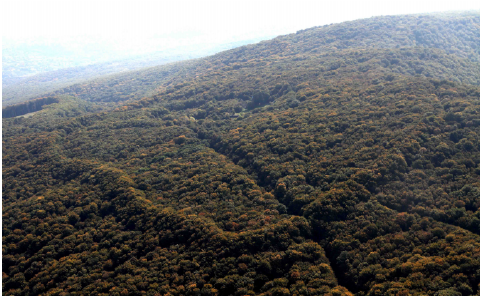
Figure 1. Prehistoric rampart in the Jakab Mountain Carpathian Basin (see Figure 1), beside which dozens of tumuli are